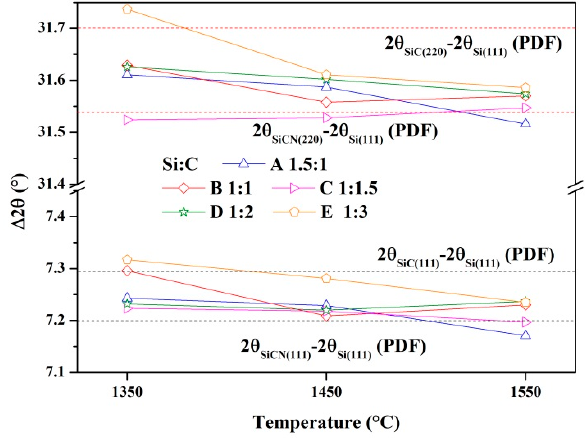
Figure 4. SiC (220) and (111) peaks’ shift of samples synthesized at different temperatures.